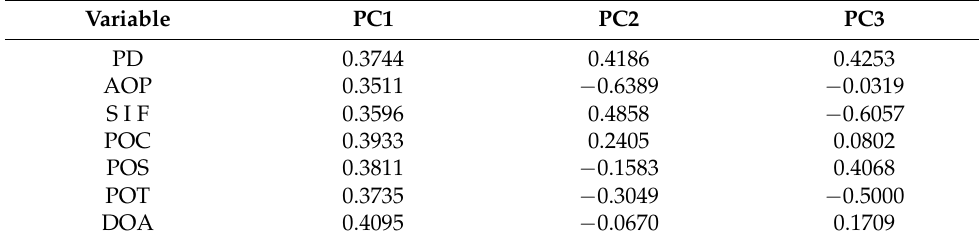
Table 5. Component-score coefficient matrix of the first three principal components.